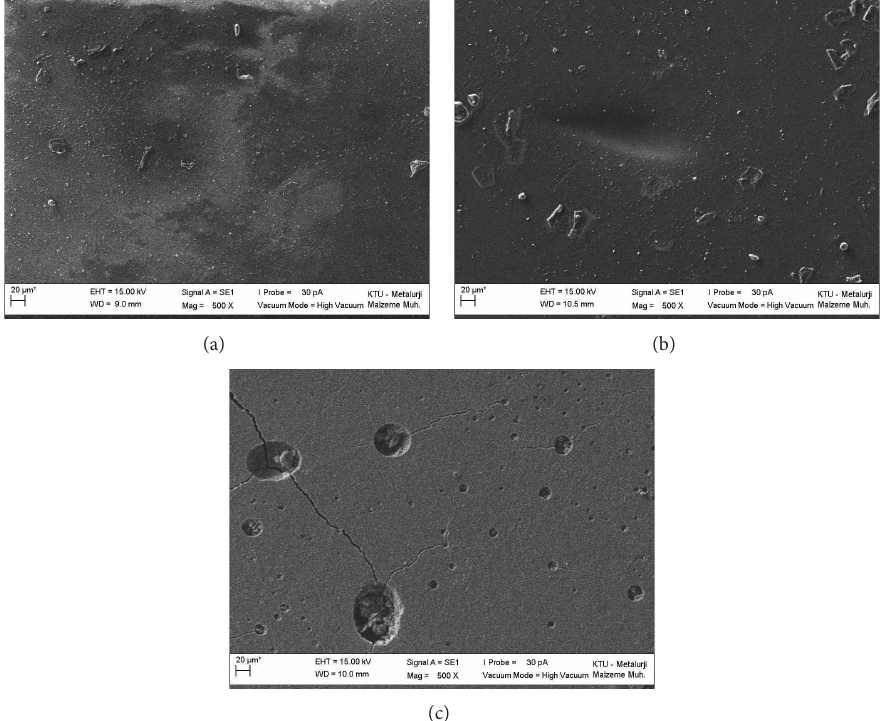
Figure 2: SEM evaluations of the samples with RC after UV. (a) Compomer, (b) nanofilled composite, and (c) microhybrid composite (Mag ×